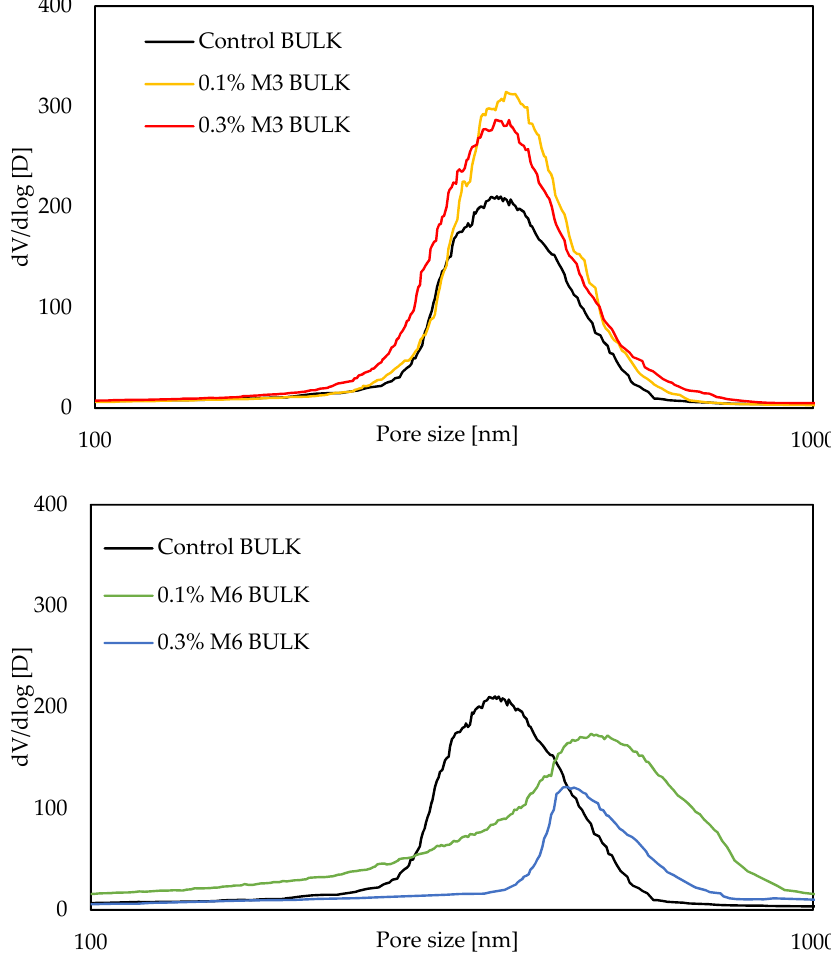
Figure 4. Pore size distributions of printed specimens with various mix compositions, measured at the bulk of the 3D printed concrete ( n = 1). Table 6. Pore characteristics obtained from mercury intrusion porosimetry for the bulk material ( n = 1).